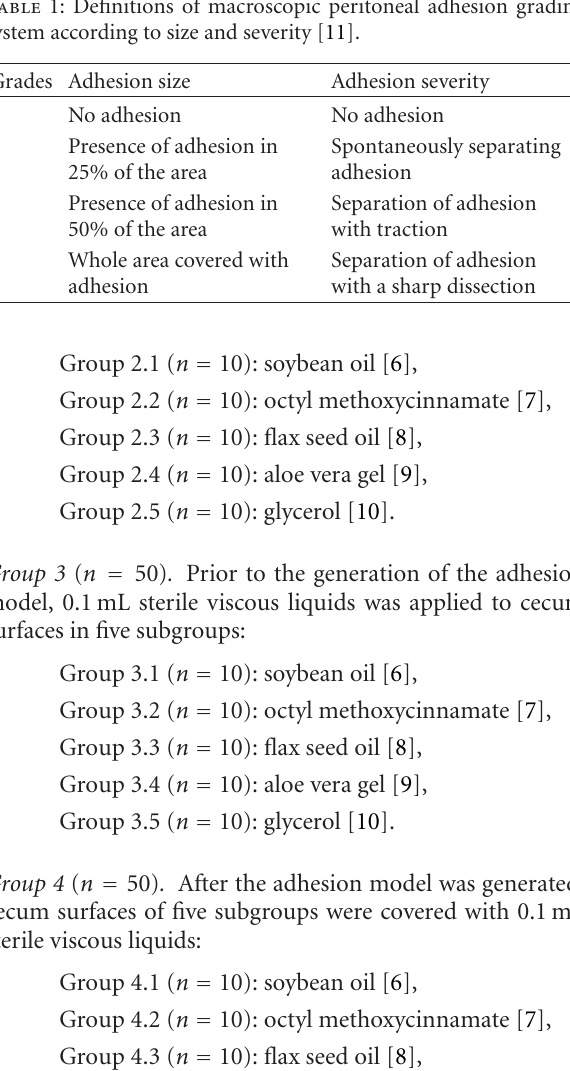
Table 1: Definitions of macroscopic peritoneal adhesion grading system according to size and severity